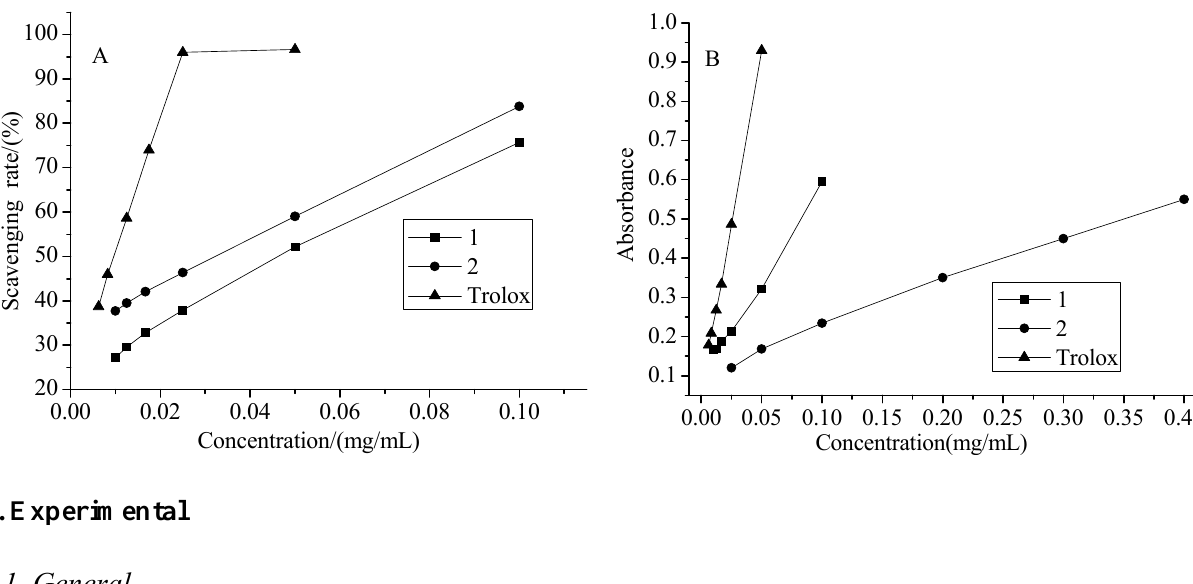
Figure 4. The antioxidant activity of compounds 1 , 2 and Trolox with different concentrations ( A: DPPH assay, B: FRAP